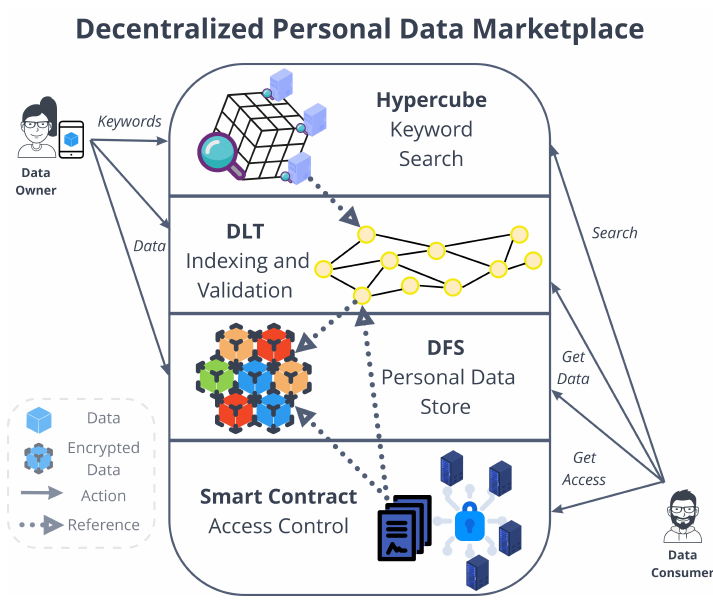
Figure 1. Decentralized data marketplace